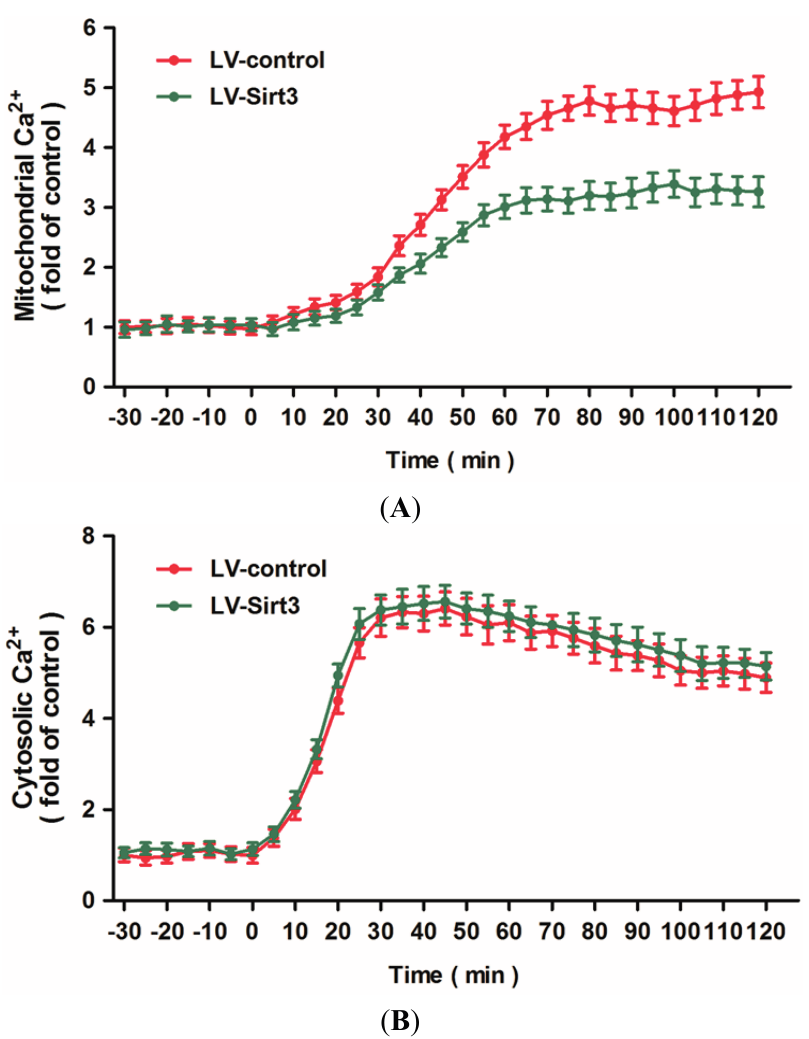
Figure 5. Overexpression of Sirt3 blocks H After transfection with lentivirus expressed Sirt3 (LV-Sirt3) or control lentivirus